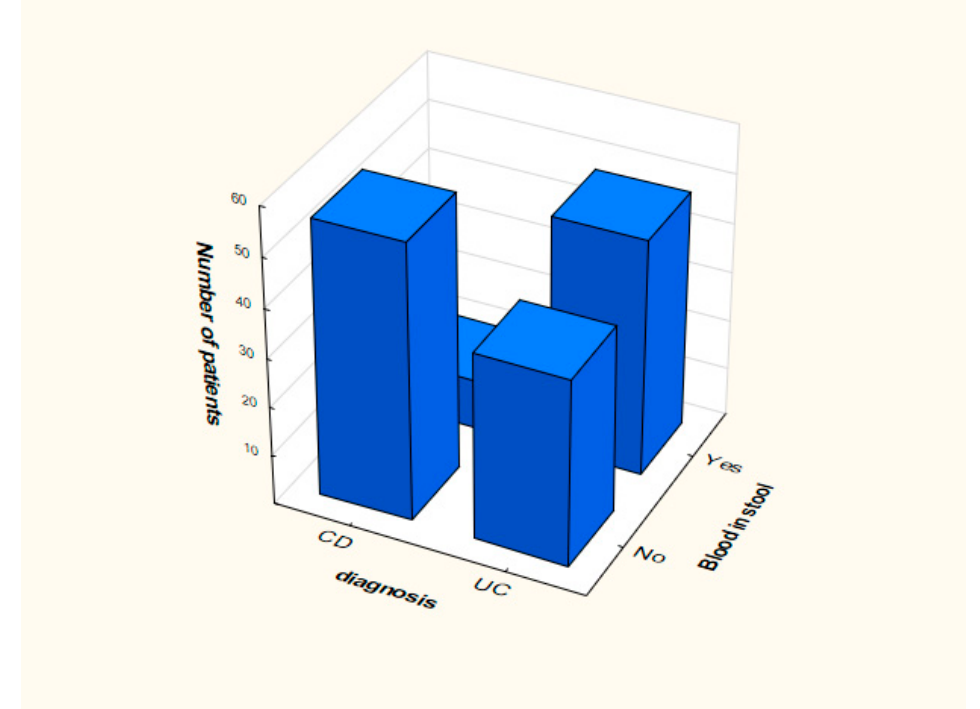
Figure 1. Distribution of data depending on the presence of blood in the stool.